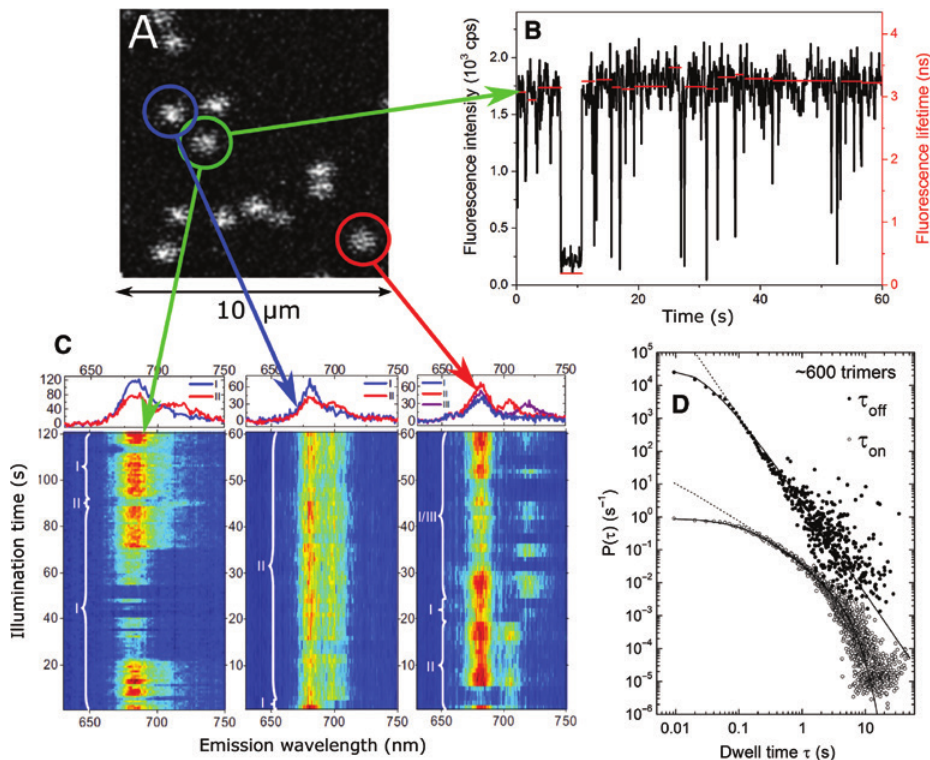
Figure 3: An illustration of a SMS measurement of individual LHCII trimers. (A) A confocal scan of a 10 μ m × 10 μ m surface area. Bright spots: fluorescence emission from single LHCs immobilized on a poly-l-lysine (PLL) covered surface. The intensity profile is given by the point-spread function. After such a scan the complexes are measured one by one. (B) A fluorescence intensity trace (black line) of a single LHCII trimer that illustrates blinking events both in the millisecond and second time range. The corresponding fluorescence lifetime (without the contribution of S-T annihilation) is depicted on the right axis (red line). Reproduced from Ref. [24] with permission from the physical chemistry chemical physics (PCCP) Owner Societies. (C) Series of recorded spectra of three selected LHCIIs, demonstrating spectral diffu- sion and state switching. Reprinted from Ref. [34] with permission of Elsevier. (D) Probability distribution of blinking events in LHCII trimers that typically show a power-law behavior for off-times from a few milliseconds to hundreds of seconds. On-times generally follow the same power-law dependence but exhibit an exponential tail at longer dwell times. Off-time data are offset for clarity. Reprinted with permission from Krüger et al. [35]. Copyright (2011) American Chemical